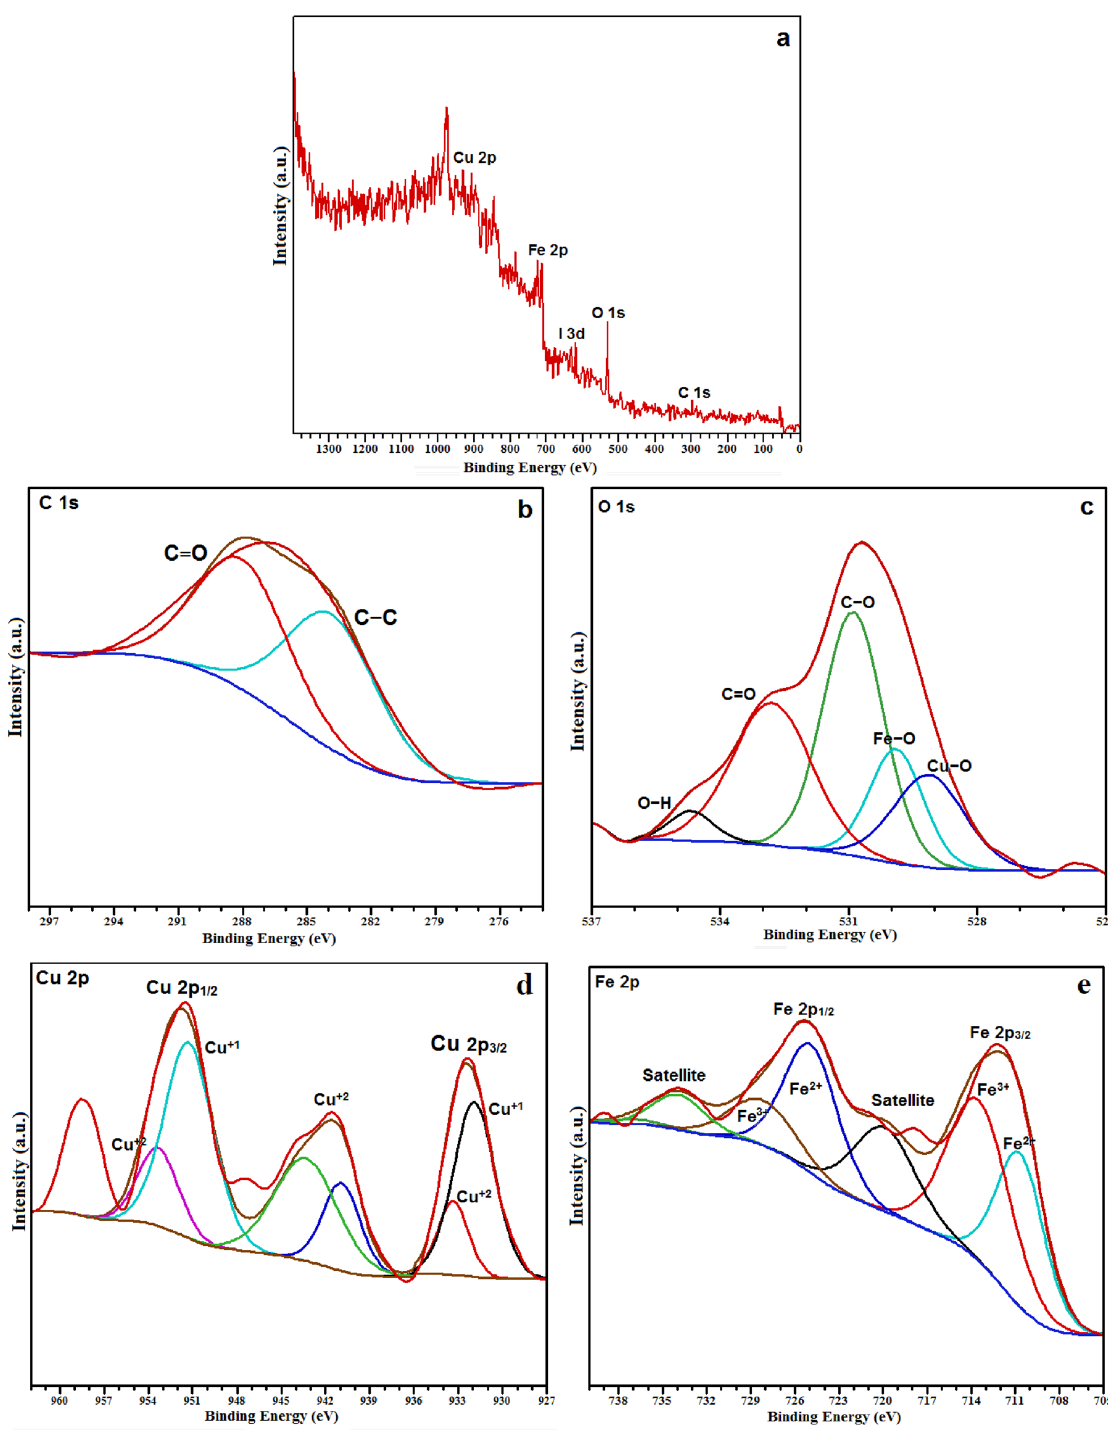
Figure 8. XPS spectrum of Fe 3 O 4 @CQD@CuI; XPS survey spectrum ( a ), C 1s ( b ), O1s ( c ), Cu 2p ( d ) and Fe 2p ( e